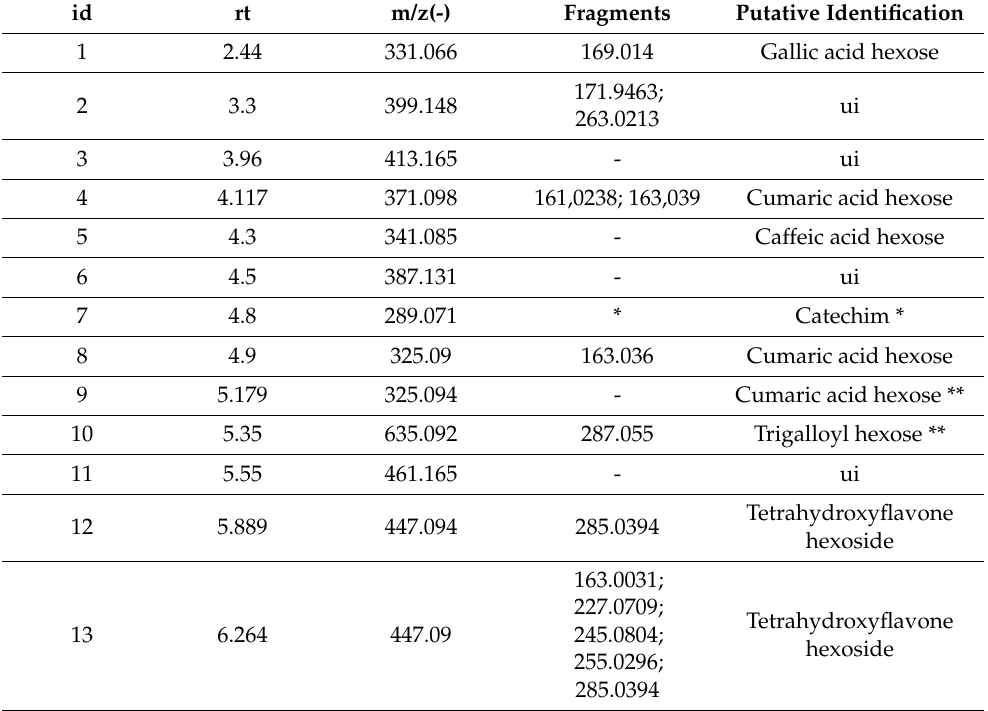
Table 2. Main metabolites of Rhus coriaria samples. The identification numbers (id) are the same as in Figure 2; 14 and 15 were not identified. Galloyl hexose was the more represented metabolite. Numerous other derivatives of gallic acid (galloyl hexose, trigalloyl hexose and high molecular weight galloyl derivatives), hydroxycinnamic acid derivatives, catechin, procyanidins and flavonoids were also detected. rt = retention time; ui = unidentified; m/z = mass-to-charge ratio * confirmed by comparison with authentic standard; ** not confirmed by